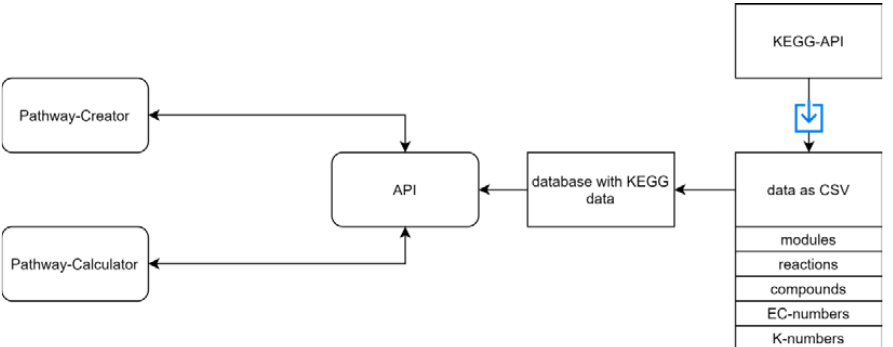
Figure 5. An overview of the REST-API. A REST-API is used for sending the required data to the ‘Pathway-Creator’ and the ‘Pathway-Calculator’. The KEGG database was downloaded as CSV files and parsed into our database. The available KEGG data include pathway modules, compounds, reactions, EC-numbers, and K-numbers. The blue arrow represents a download of specific files.